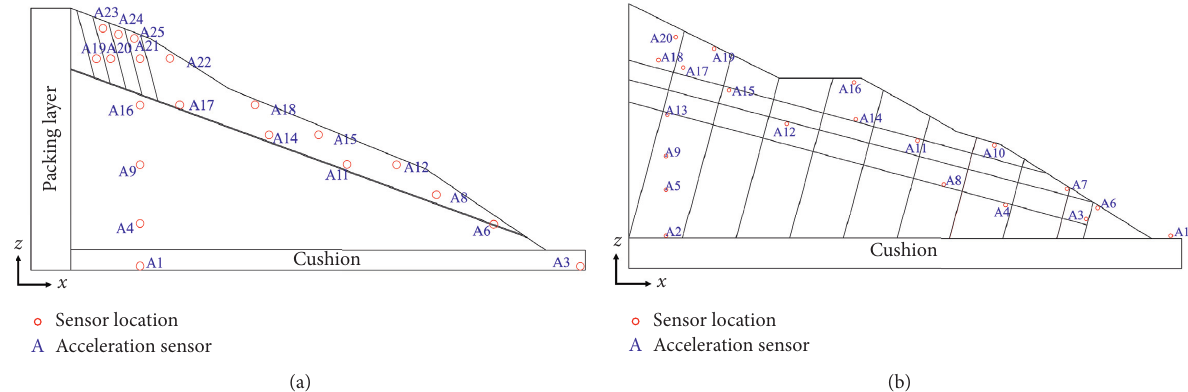
Figure 12: Acceleration sensor distribution (unit: mm): (a) Huaping slope; (b) Lijiang slope.